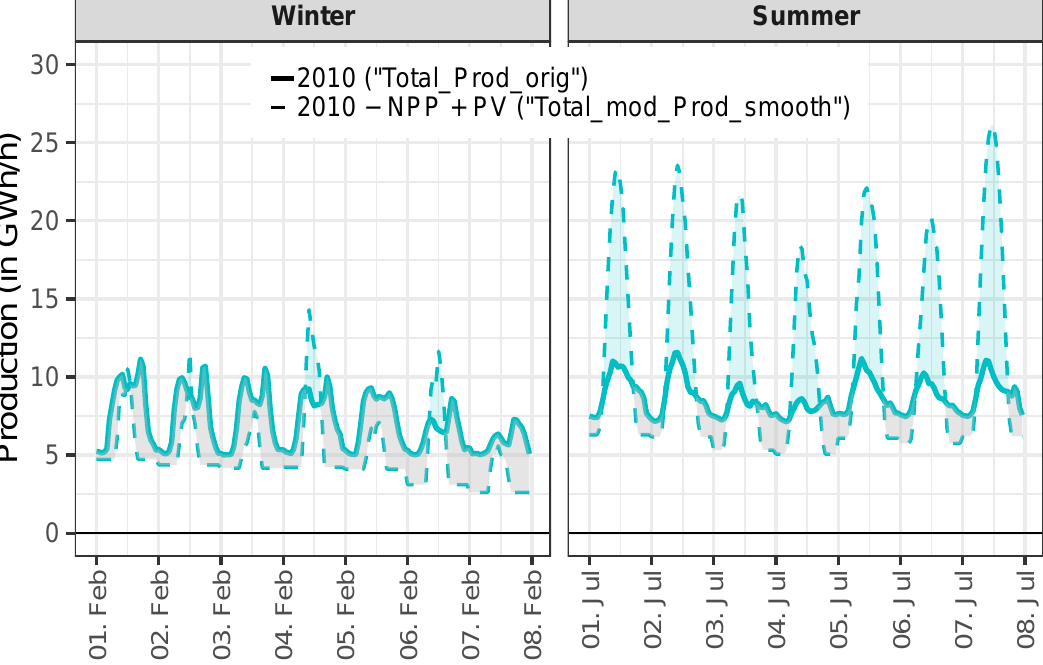
Figure 19. Comparison of the total hourly electricity production for the original (“Total_Prod_orig” in Table 1) and modified profile (with PV and no nuclear power plants (NPP); “Total_mod_Prod_smooth” in Table 1) in a randomly selected week in winter and summer. Positive differences are shaded in blue; negative differences are shaded in